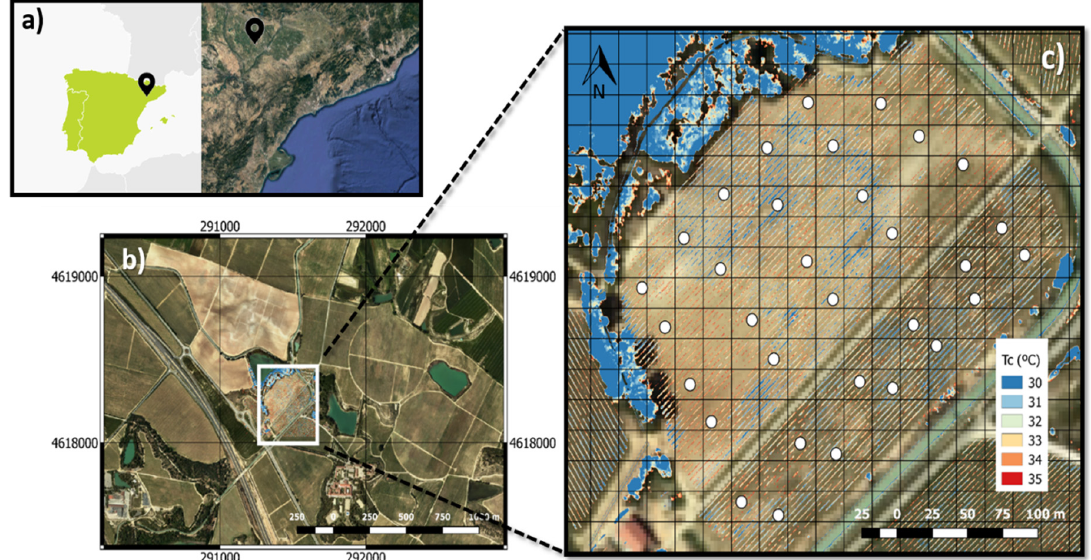
Figure 1. Location of the ( a ) study area at Raimat (Lleida, Spain). The white square in ( b ) shows the location of the vineyard. This is shown in greater detail in ( c ), through a canopy temperature ( T c ) map obtained from a very high-resolution airborne thermal image. The white dots indicate the location of the 32 measured vines within the vineyard. The black squares show each sharpened 20-m pixel coinciding with the resolution of the biophysical parameters obtained from Sentinel ‐ 2.